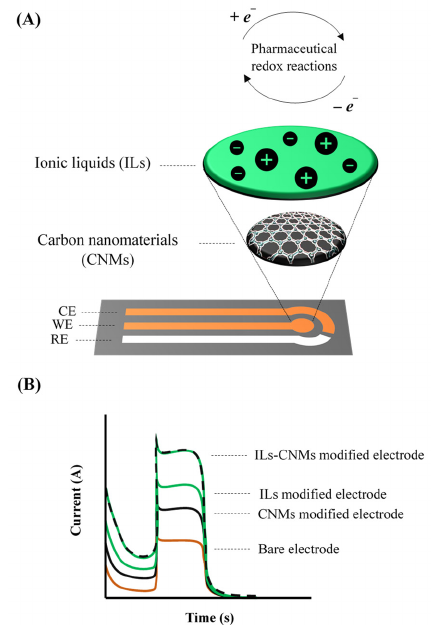
Figure 3. ( A ) Simplified assembly scheme of electrochemical sensors based on ionic liquid-functionalized carbon nanocomposites, along with the drug detection principle. ( B ) Matching electrochemical signal.